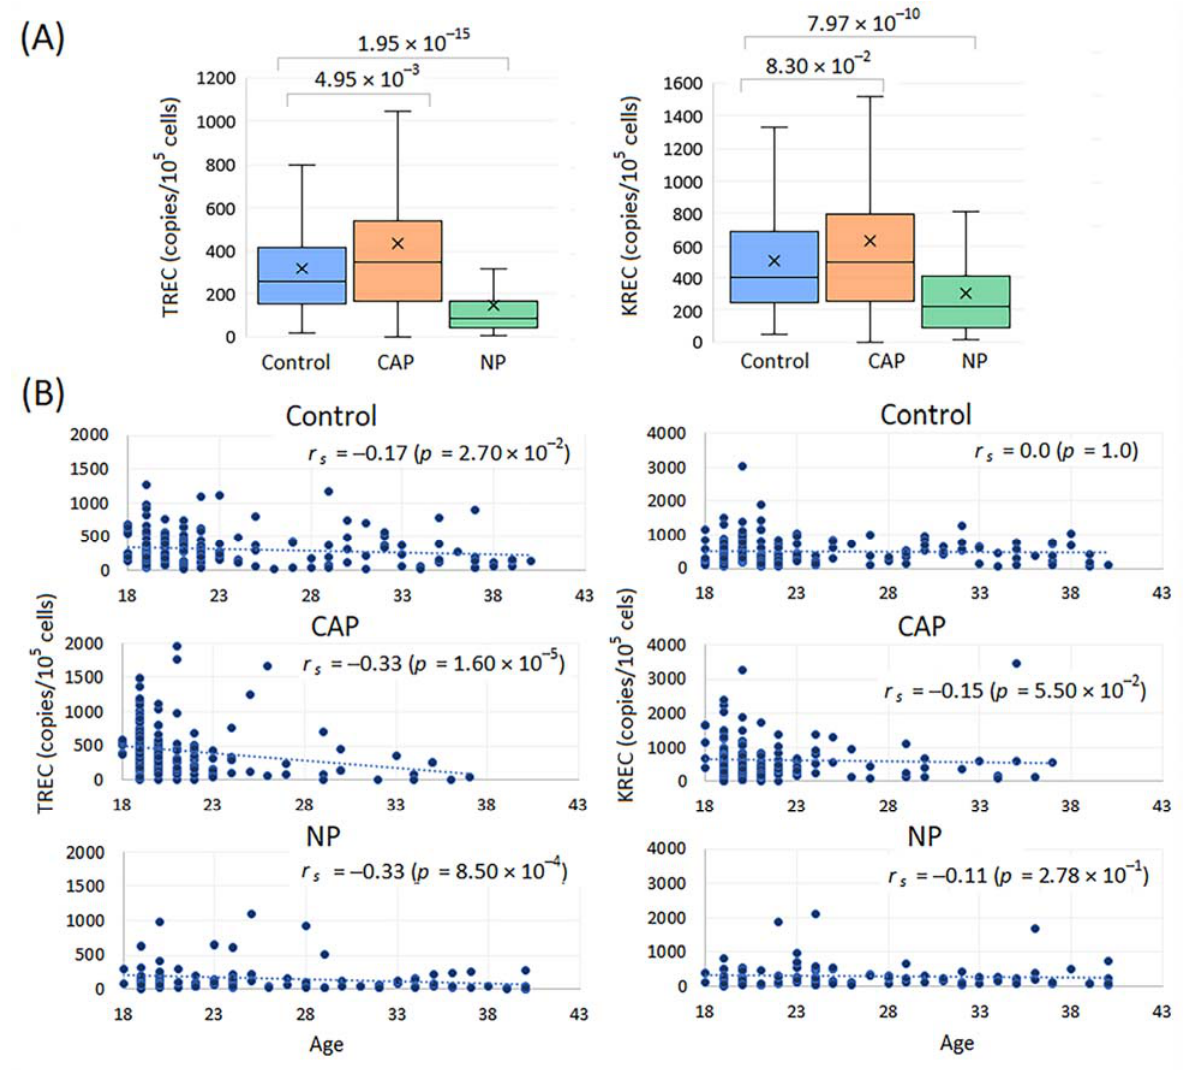
Figure 4. TREC/KREC counts in healthy controls and patients with CAP and NP. ( A ) Boxplots depicting differences between TREC/KREC levels in healthy controls and patients with community- acquired (CAP) and nosocomial (NP) pneumonia. ( B ) Scatterplots showing the correlation between age and TREC/KREC levels in healthy controls and patients with CAP and NP. Spearman’s rank correlation coefficient r s and associated p ‐ value (one tail) are indicated.